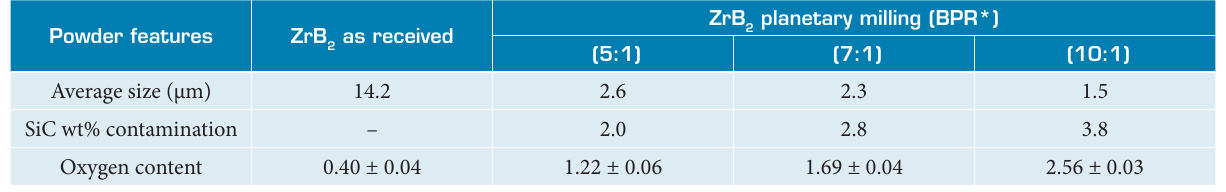
Table 1. Results of average size, SiC contamination and oxygen content of the as-received ZrB and after planetary milling with different BPR.